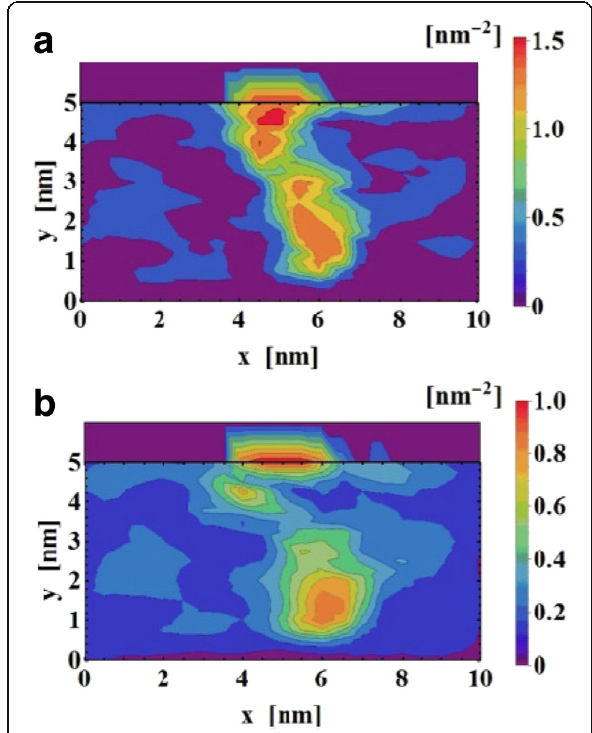
Fig. 14 Resistive switching layer and Ti/HfO 2 interface oxygen spatial density (No) plot during the CF rupture using negative bias: a initial and b final